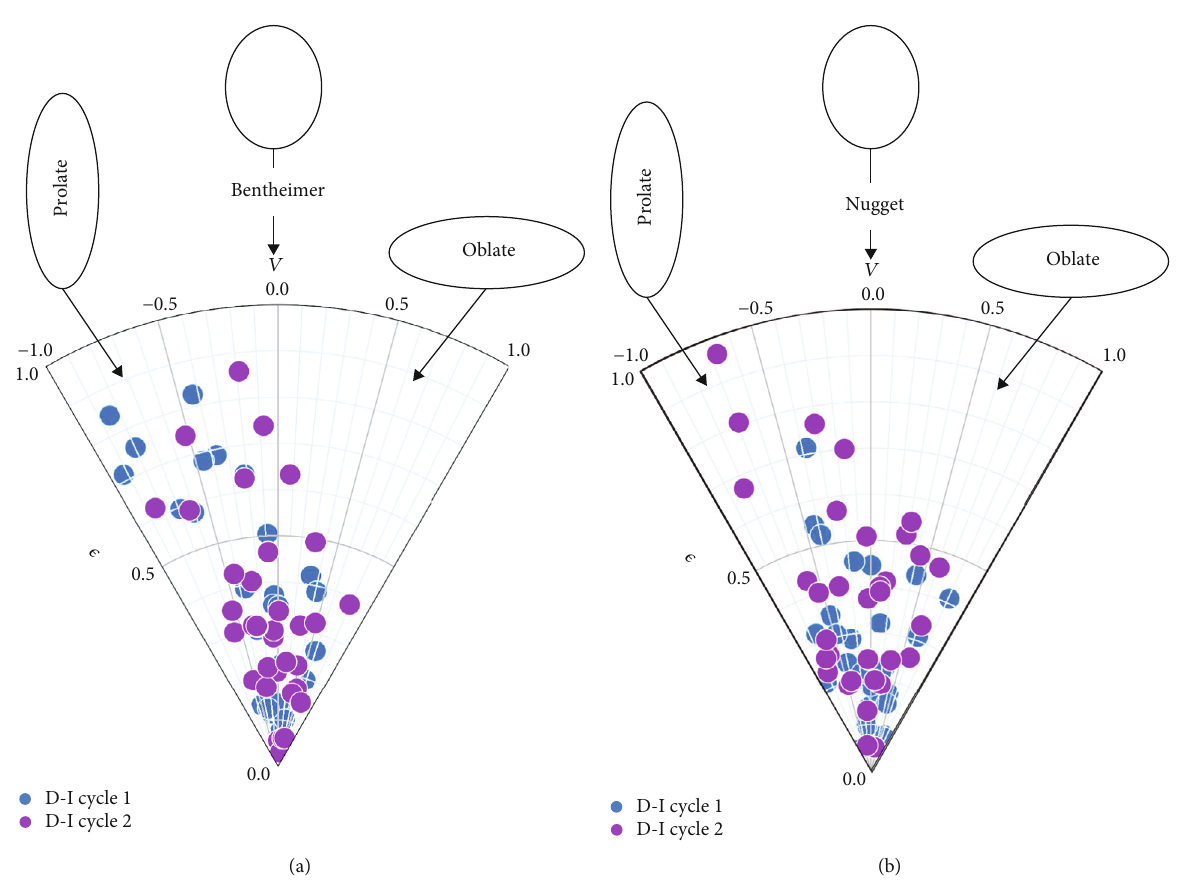
size distributions (SSD): (a) Bentheimer and (b) Nugget. 2